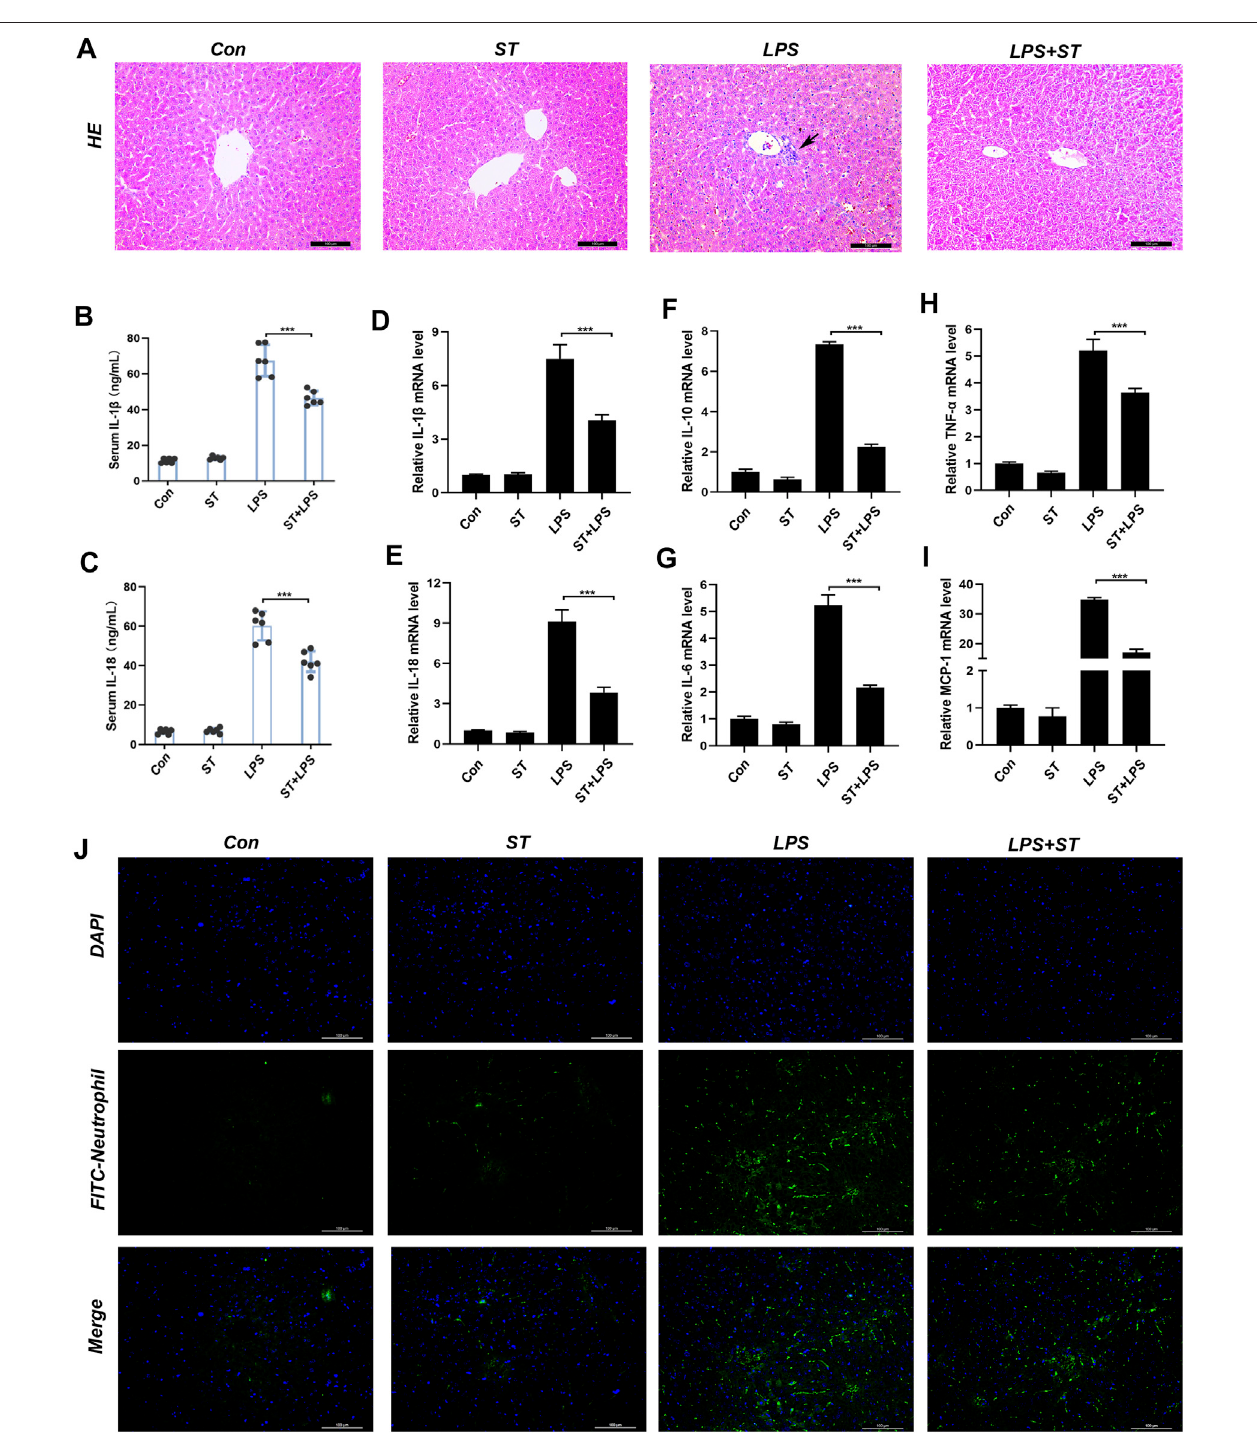
FIGURE 3 | Samotolisib reduces the LPS-induced in fl ammatory response. Liver tissues were collected from the mice 12 h after LPS administration. The following analyses were performed: (A) H&E staining was performed on paraf fi n-embedded mouse liver sections. In fl ammatory foci were observed using a microscope (Scale bar (cid:1) 100 μ m). (B, C) Serum IL-1 β and IL-18 levels measured using ELISA. (D – I) mRNA expression of the in fl ammatory cytokines IL-18, IL-1 β , IL-6, IL-10, MCP-1, and TNF- α , quantitated using qRT-PCR. (J) Immuno fl uorescence assays. Immuno fl uorescence was performed on frozen mouse liver sections. 4 ′ ,6-diamidino-2-phenylindole (DAPI)counter-staining for visualizing nuclei.Stainedsectionswereobserved and quanti fi edusing a fl uorescencemicroscope (scalebars (cid:1) 100 μ m).Dataare presented as the mean ± SD; * p < 0.05, ** p < 0.01, *** p < 0.005.